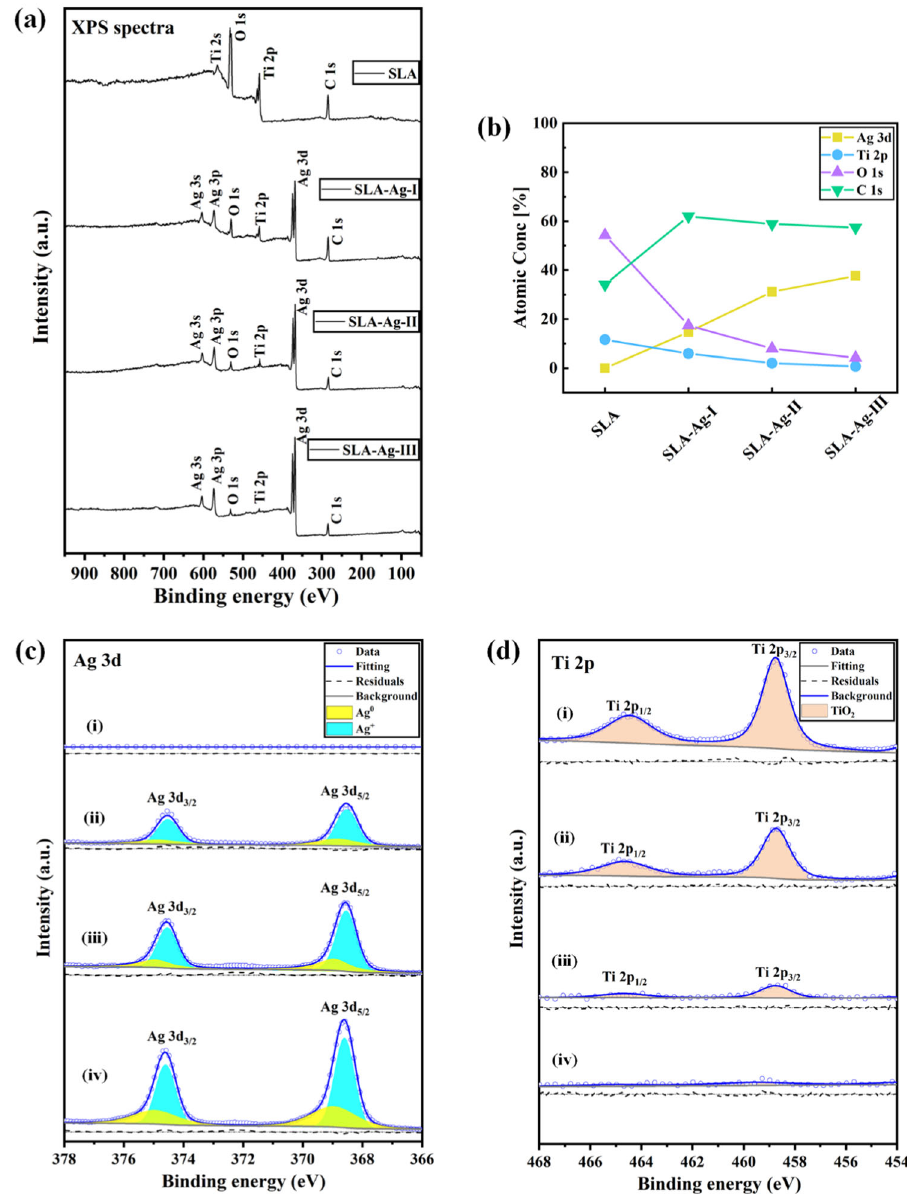
Fig. 2 XPS results of four experimental groups (SLA, SLA-Ag-I, SLA-Ag-II, and SLA-Ag-III). a Wide scan XPS spectra. b XPS depth-pro fi le of four groups. Detailed spectra of ( c ) Ag 3d and ( d ) Ti 2p